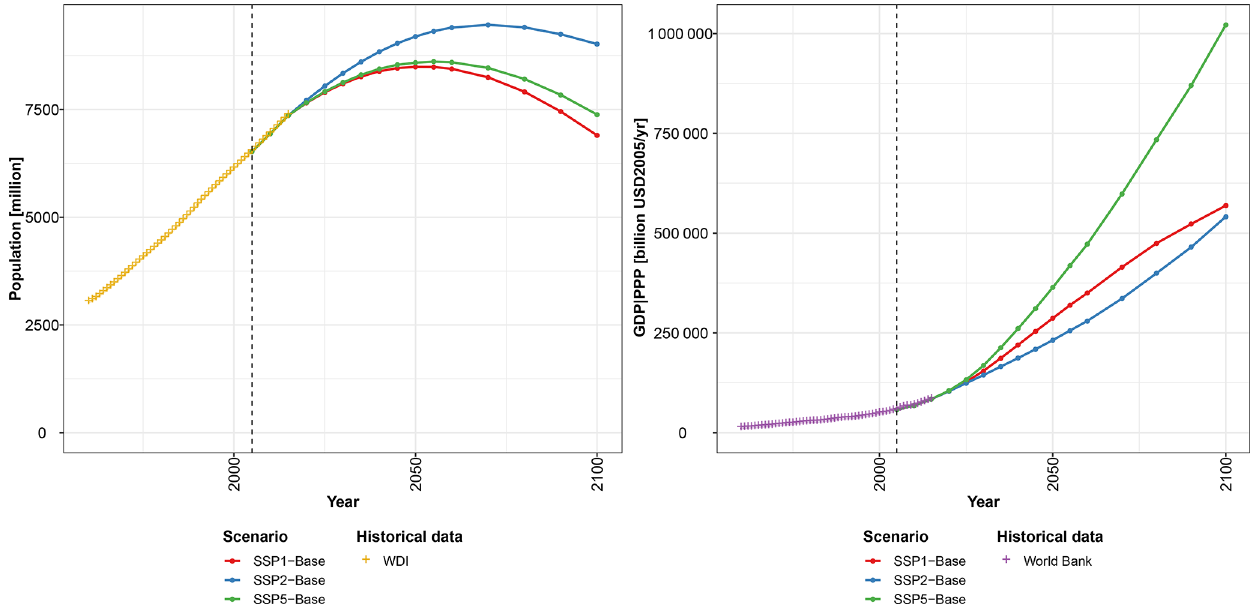
Figure 2. Global population and GDP trajectories for 2005 to 2100 for SSP1, SSP2, and SSP5, compared to historical data from the World Development Indicator (WDI) and World Bank